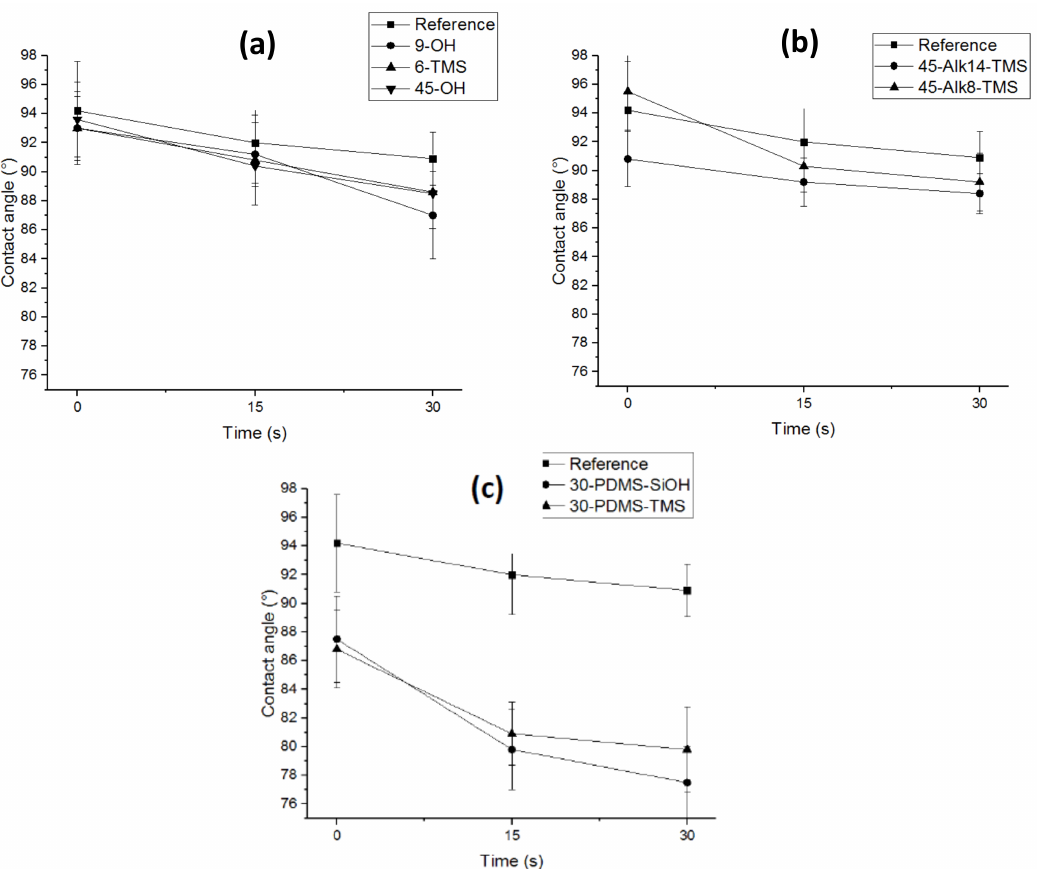
Figure 5. All hydrophilic additives were incorporated in the PDMS 13 -matrix-ended methoxy. ( a ) Water contact angle of hydrophilic additives with no linker. ( b ) Contact angle of hydrophilic additives with linker alkyl. ( c ) Contact angle of PEG additives with linker